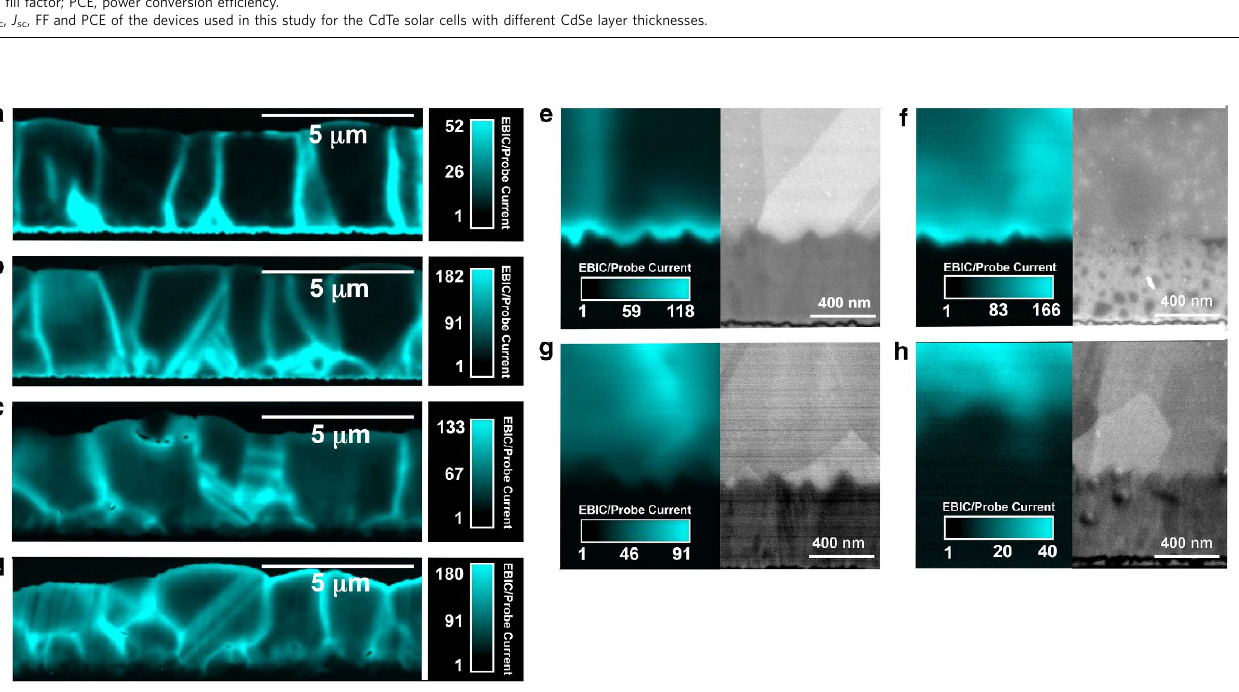
Figure 2 | Cross-sectional EBIC maps. ( a – h ) Cross-sectional EBIC maps of the devices prepared with ( a ) 50, ( b ) 100, ( c ) 200 and ( d ) 400nm-thick CdSe layers. The associated contrast bars represent the EBIC current divided by the probe current (no units). SE-SEM images and simultaneously acquired EBIC maps of the devices with ( e ) 50, ( f ) 100, ( g ) 200 and ( h ) 400nm CdSe layers. The 50 and 100nm CdSe layers do not have small CdSe grains interfacing the FTO, while the 400nm sample shows small CdSe grains interfacing the FTO. The EBIC map combined with the SE-SEM image for the 400nm CdSe layer sample ( h ) shows that the small CdSe grains interfacing the FTO are not